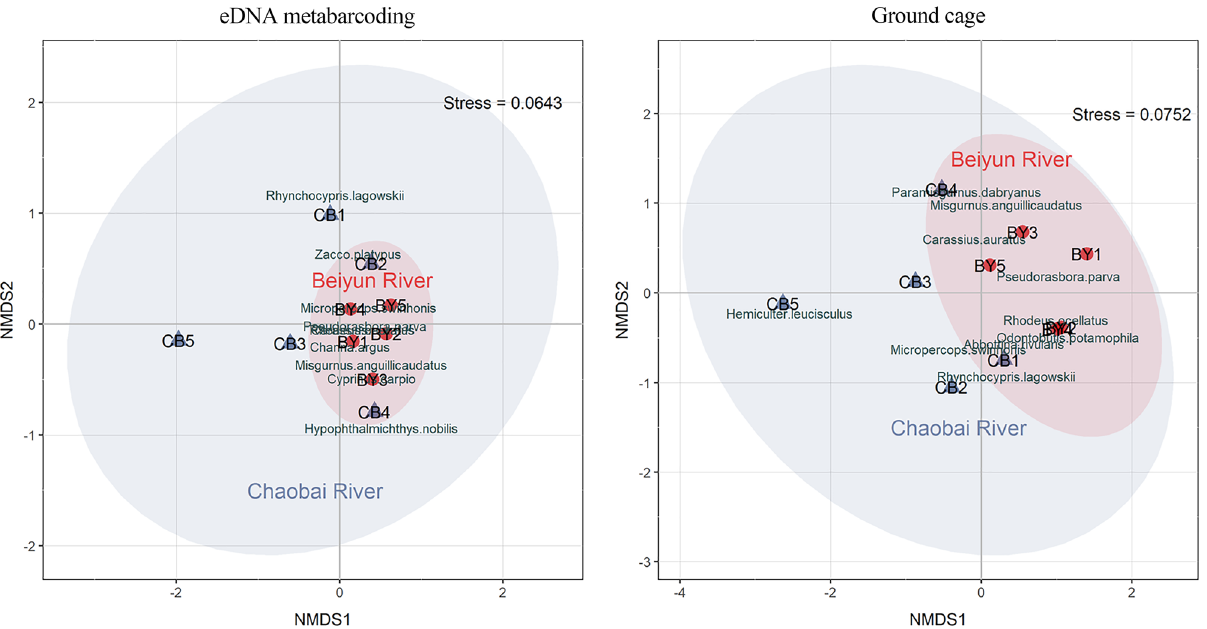
Figure 7. Community variation based on Bray–Curtis dissimilar non-metric multiscale (NMDS) sorting: the left panel is based on the results of eDNA metabarcoding; the right panel is based on ground cage